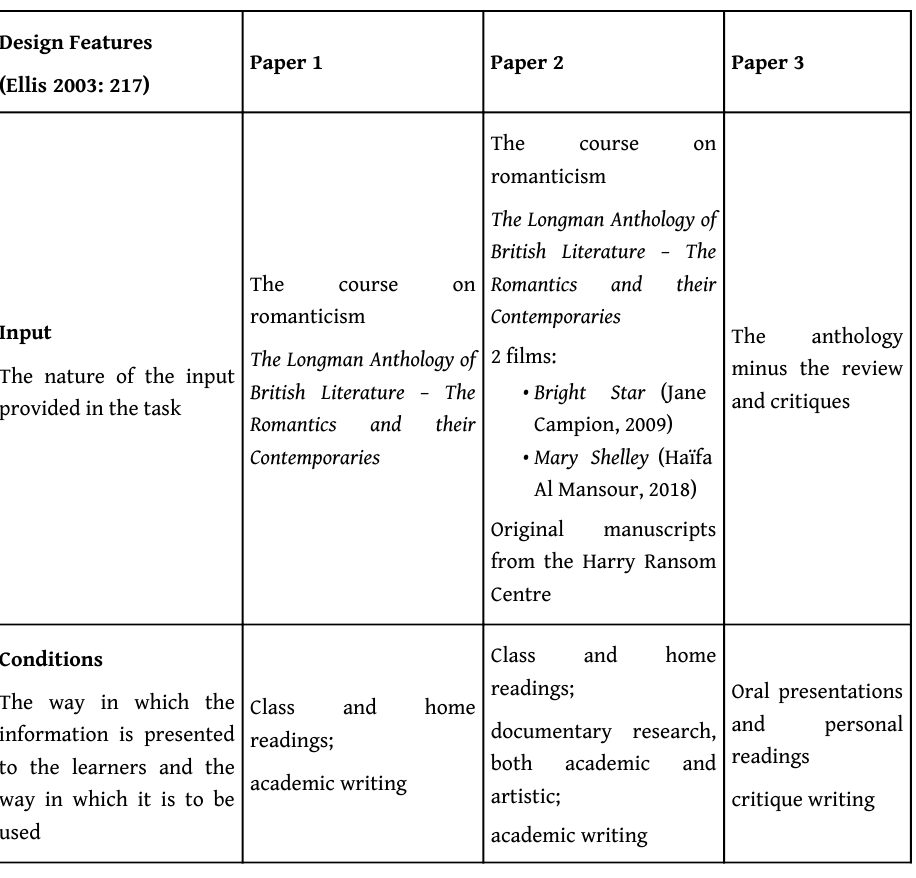
Table 3: The project’s design features according to Ellis’s model